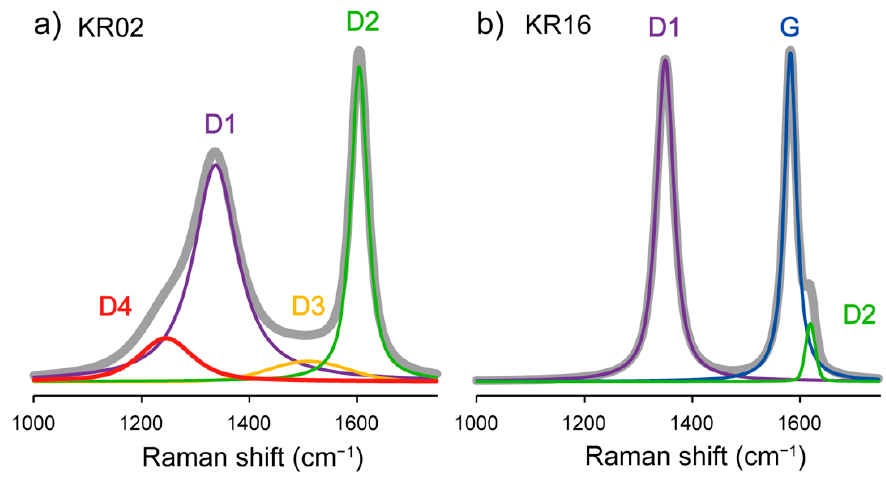
Figure 4. Schematic illustration showing examples of peak separation from measured Raman spectra (gray line): ( a ) KR02 and ( b ) KR16.